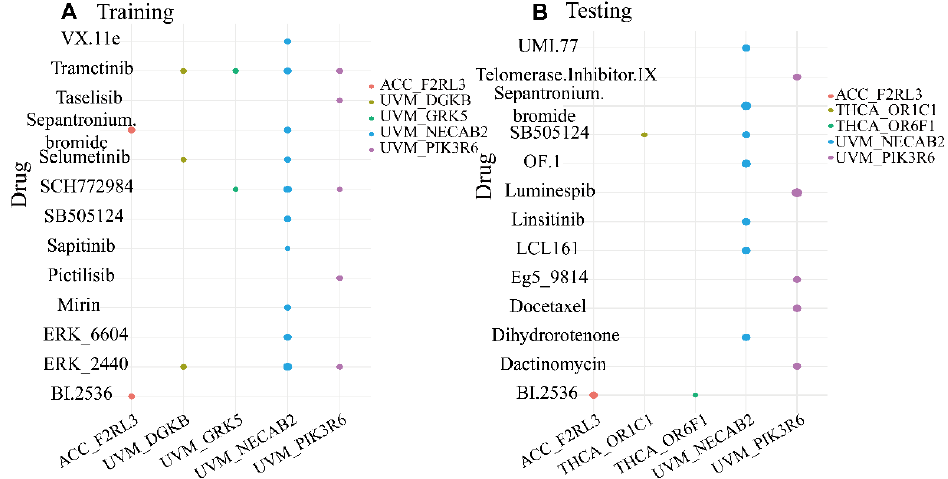
Figure 6. Significantly correlated GRSDMs and IC50 of drugs. ( A ) IC50s of drugs for significantly correlated GRSDMs in the training set. ( B ) IC50s of drugs for significantly correlated GRSDMs in the testing